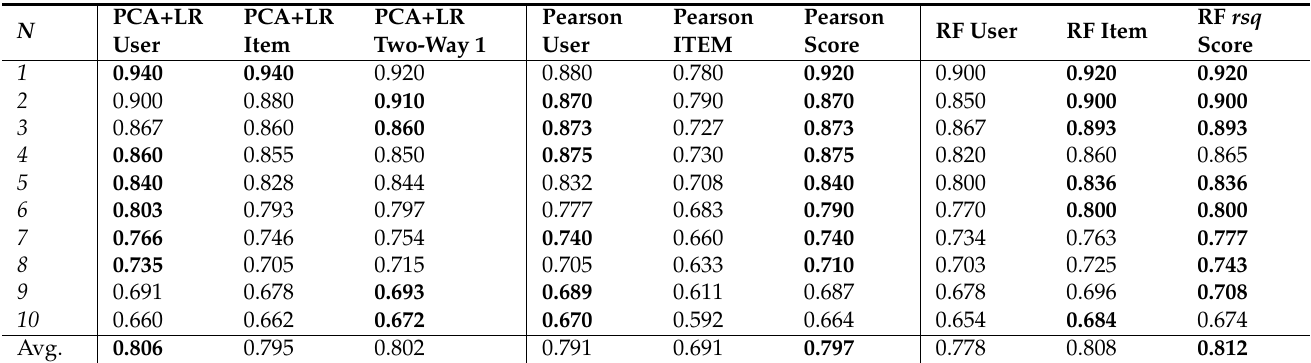
Table 4. Top- N accuracy for case